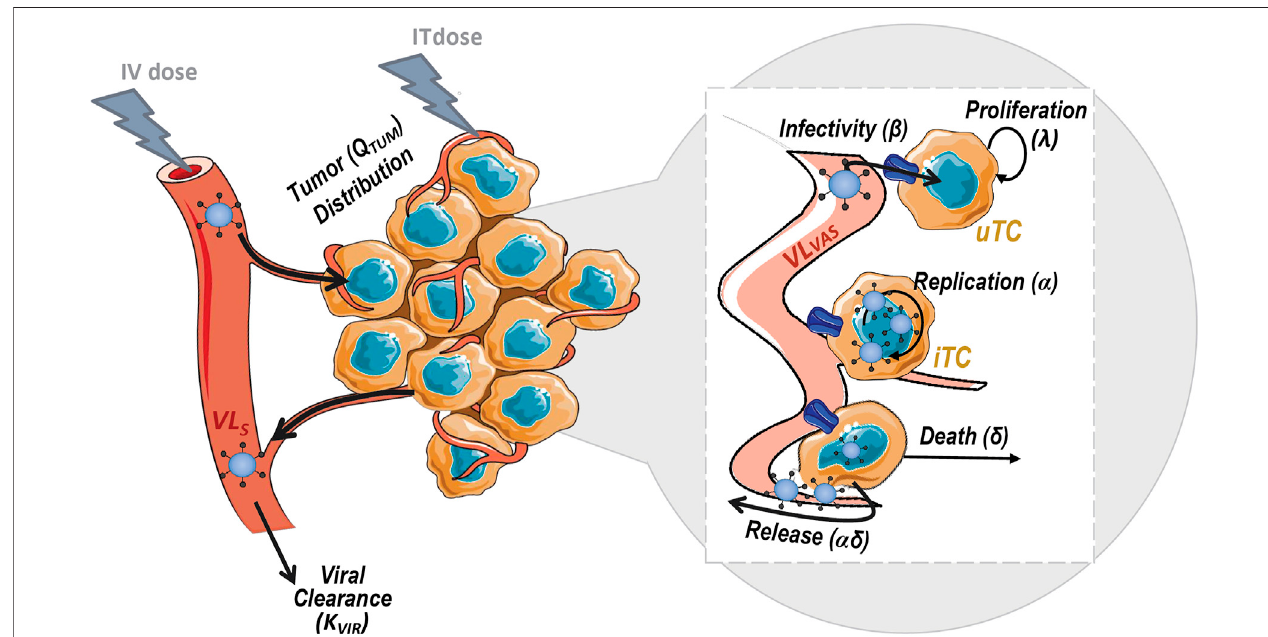
FIGURE2| Schematicrepresentationofthemechanisticmodelforviralkinetics,viraldynamicsandtumorgrowth.uTC,uninfectedtumorcells;iTC,infectedtumor cells; VL S , serum viral load and VL VAS , viral load in tumor vasculature.